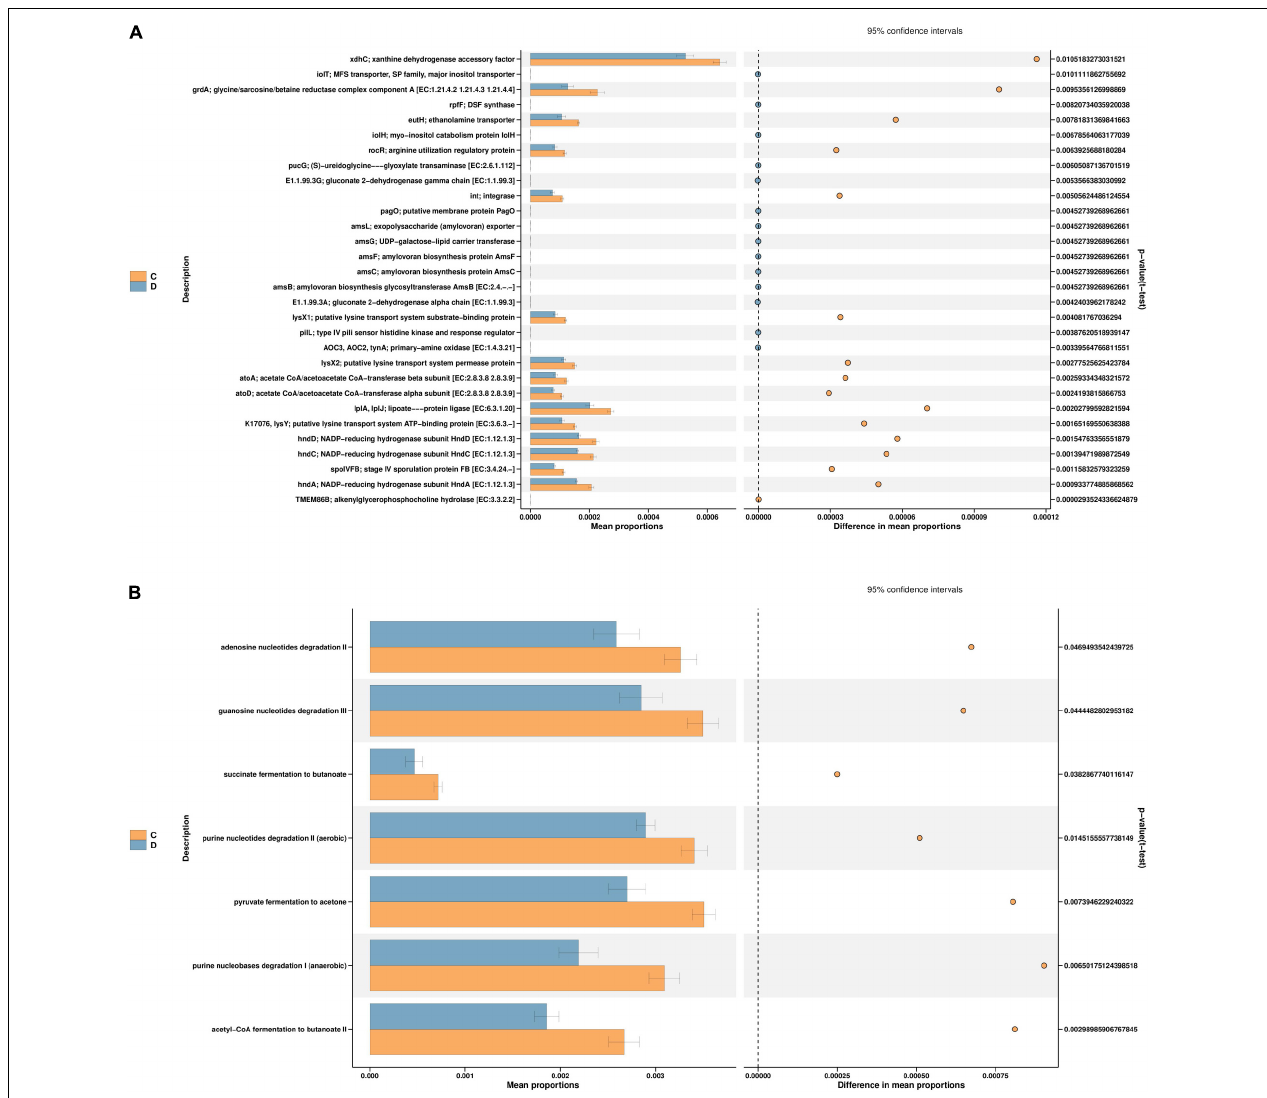
FIGURE 7 | Function prediction ( n = 6). (A) PICRUSt2 KO group C vs. D. (B) PICRUSt2 pathways group C vs. D. In the figure, C and D represent HFD and HFD + MBPs,